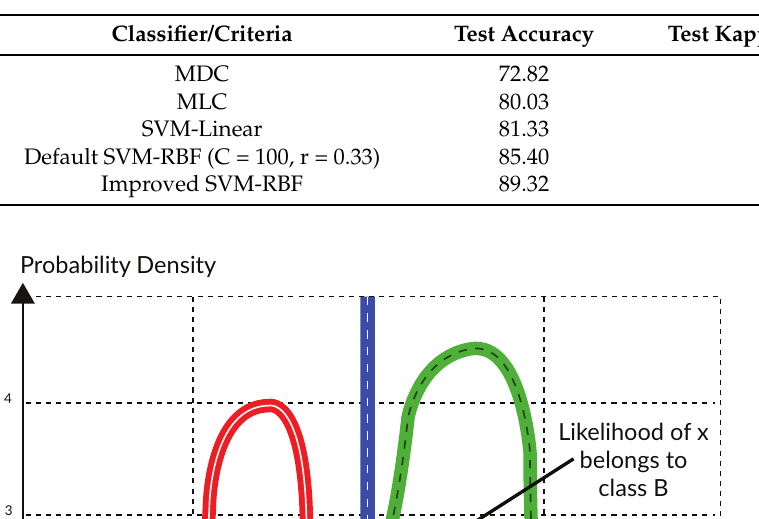
Table 2. Accuracy assessment of the classifiers on the test set.